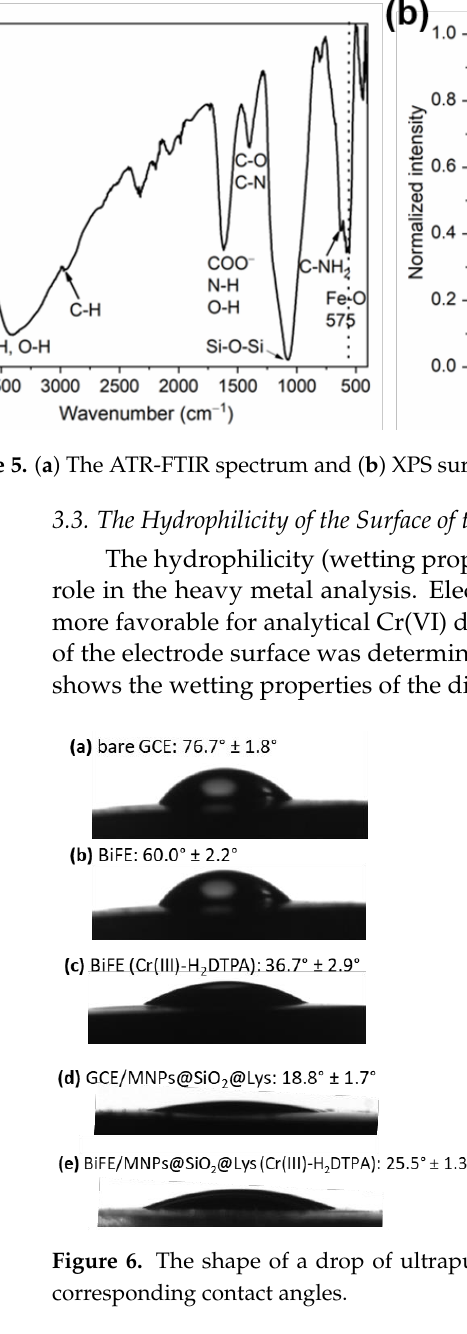
9 of 16 Figure 4. ( a ) FE-SEM image and ( b ) TEM image at lower and higher magnification (shown in the inset) for MNPs@SiO 2 @Lys. The black arrows in the inset of Figure 4b denote the silica coating. In addition, ATR-FTIR analysis revealed the presence of MNPs@SiO 2 @Lys constitu- ents, i.e., maghemite, the amorphous silica layer, and derived lysine on the MNCs (Figure 5a). The peak at 575 cm –1 (Figure 5a) corresponds to the Fe-O vibrations in Fe 2 O 3 , which represents the magnetic core [63] and again confirms the presence of MNPs. The presence of a SiO 2 layer in MNPs@SiO 2 was confirmed by the asymmetric Si-O-Si stretching vibra- tions with a peak at about 1080 cm –1 [64]. The peak at 627 cm –1 is assigned to the C-NH 2 vibrations from the derived lysine backbone, while the peak at 1404 cm –1 is attributed to the C-O and C-N groups, both from the derived Lys [65,66]. The latter indicates the pres- ence of the derived lysine layer. The peak at 1625 cm –1 corresponds to the -OH vibrations of the silanol groups of Si-OH, while the -(C=O)-O and N-H functional groups demon- strate the presence of the derived Lys [50].